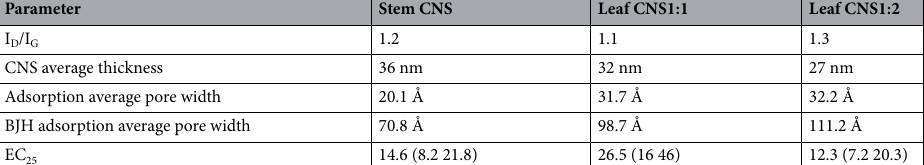
Table 2. Comparison of surface and structural parameters of the nettle-derived CNS for the effect toxicity using P. subcapitata . EC 25 (mg/L, with the 95% confidence intervals between parentheses) are indicated for comparative